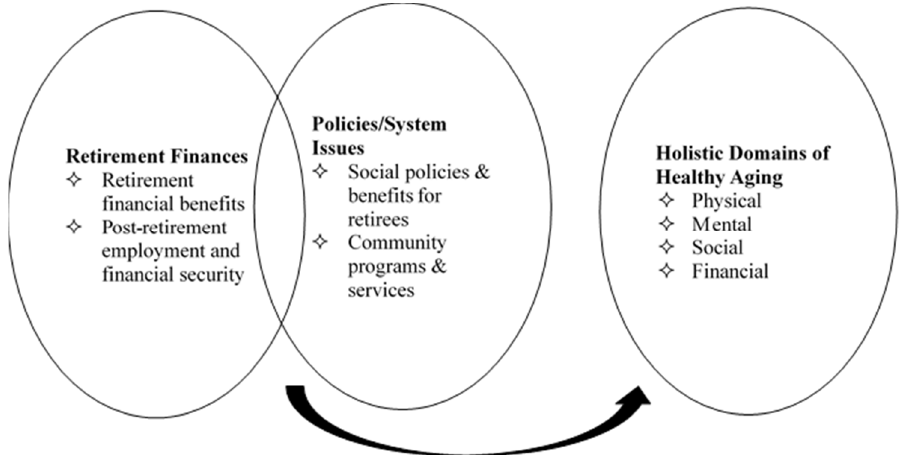
Figure 1. Conceptual framework of current study.